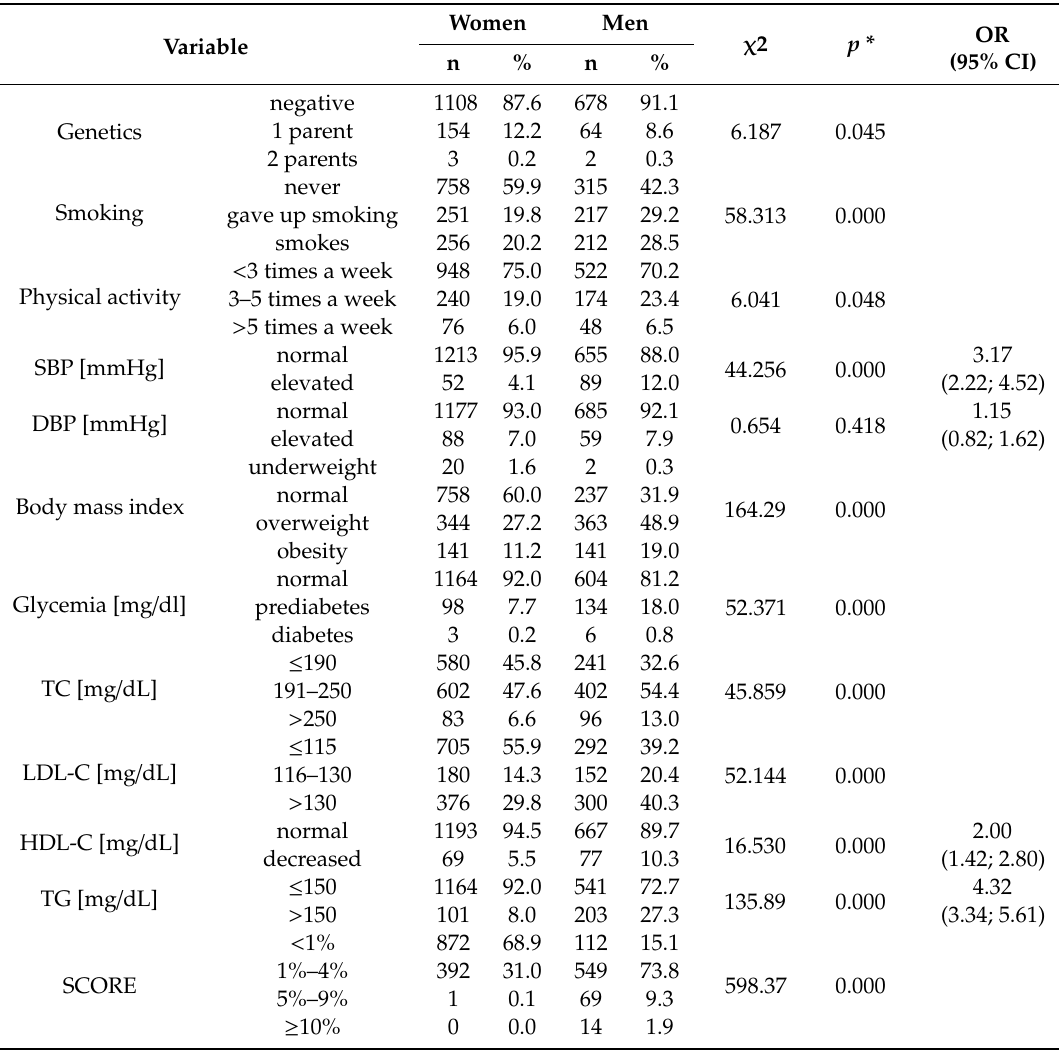
Table 2. Selected parameters with regard to